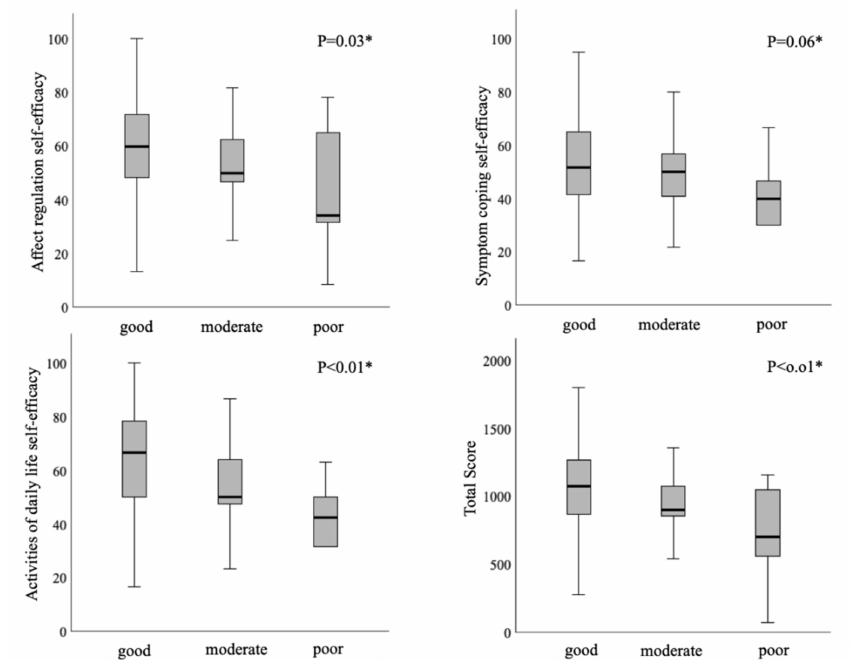
Figure 1. Stepwise correlation between the Self-e ffi cacy Scale for Advanced Cancer (SEAC) and the Functional Oral Intake Scale (FOIS) using the Jonckheere–Terpstra